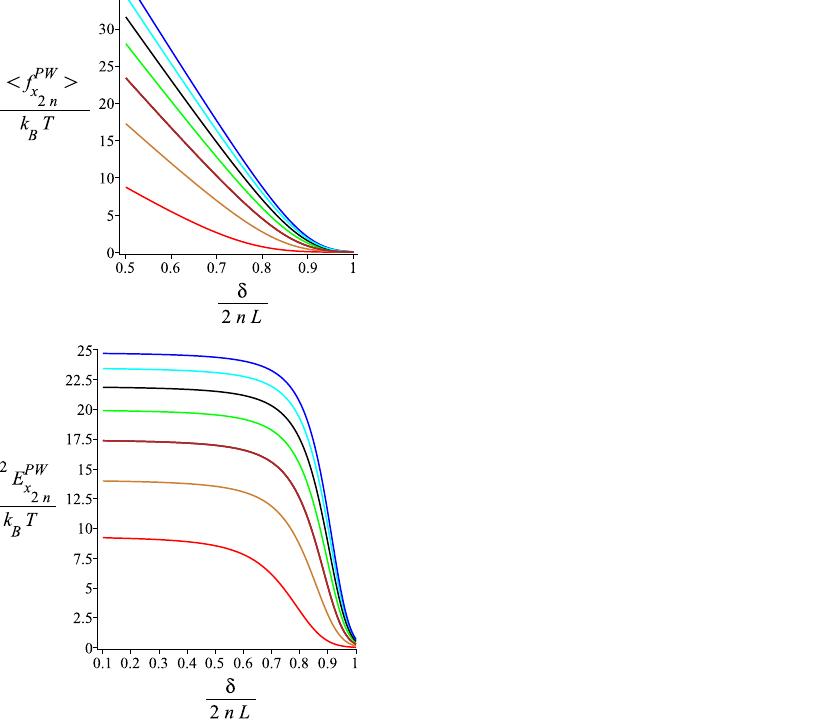
n = 2, , φ µ = 0, φ B = π 9 4 9